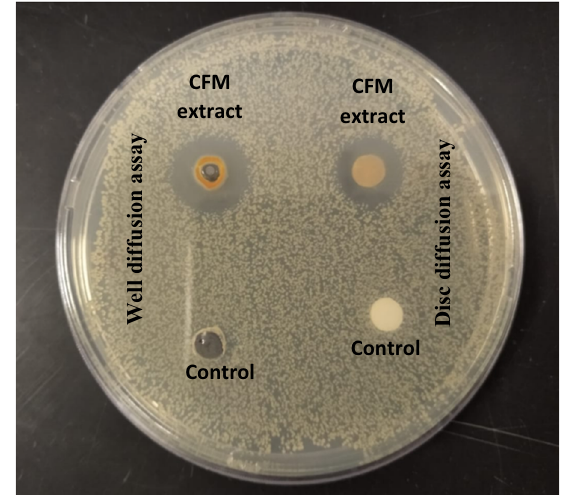
Figure 2: Petri dishes revealing zones of inhibition produced by MFC extract on methicillin - resistant Staphylococcus aureus ( MRSA ) using disc and well di ff usion